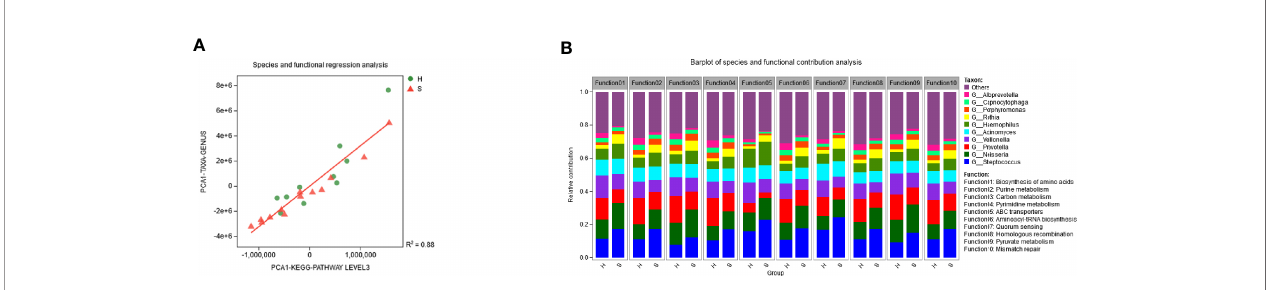
FIGURE 5 | Relationships of microbiota and functions. (A) The microbial and functional regression analysis. The microbial community diversity was based on genus level and the functional diversity was based on KEGG pathway level 3. (B) Relative contribution of different genera to identi fi ed the enriched functional attributes in the